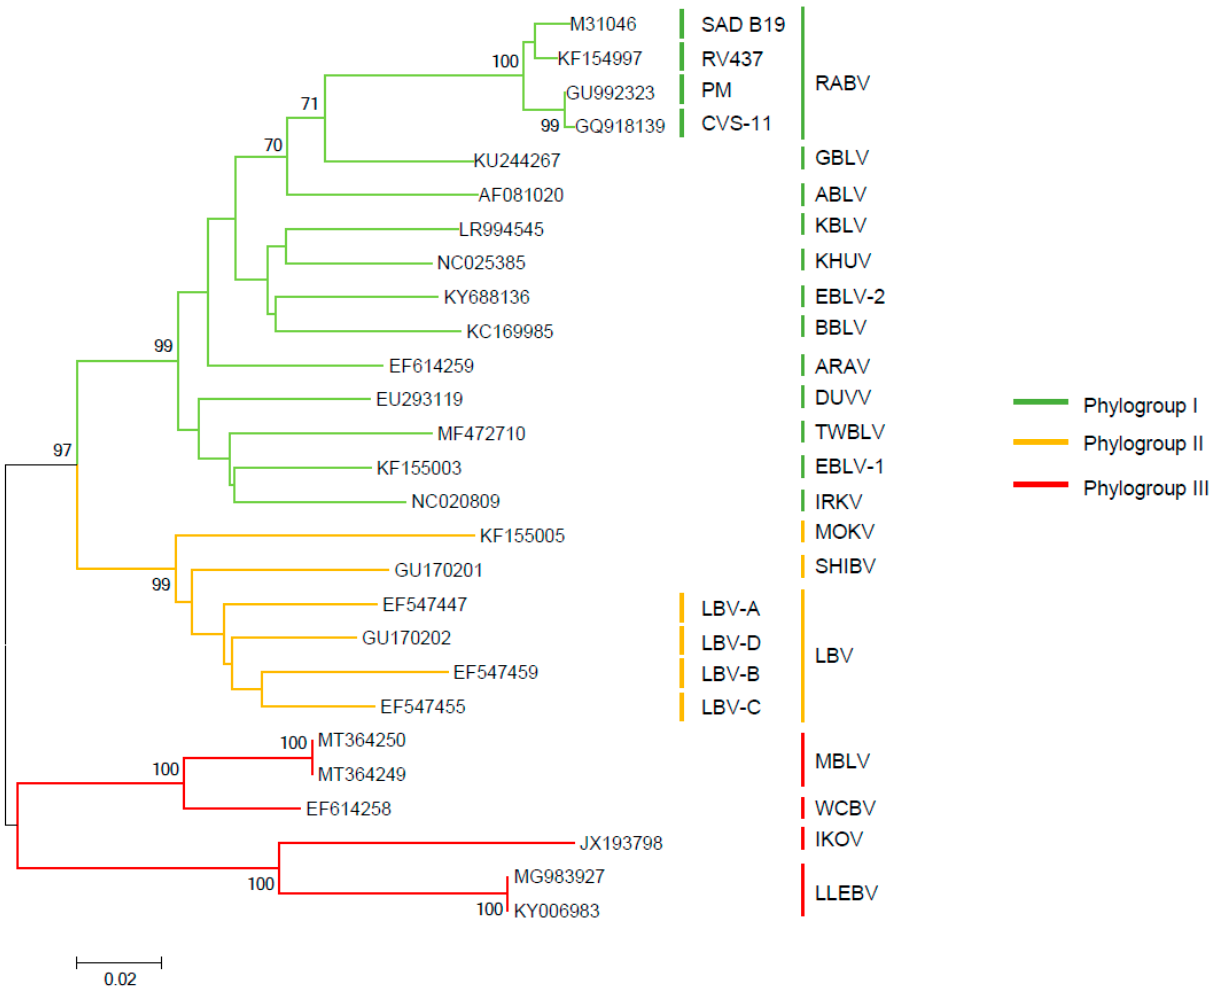
Figure 1. Phylogenetic reconstruction by inference of nucleoprotein gene sequences of lyssaviruses using the Neighbour- Joining method. The percentage of replicate trees in which the associated taxa clustered together in the bootstrap test (1000 replicates) are shown next to the branches. The GenBank accession numbers are indicated for each sequence. The evolutionary distances were computed using the Maximum Composite Likelihood method and are in the units of the number of base substitutions per site. Phylogenetic tree was generated in MEGA 6.